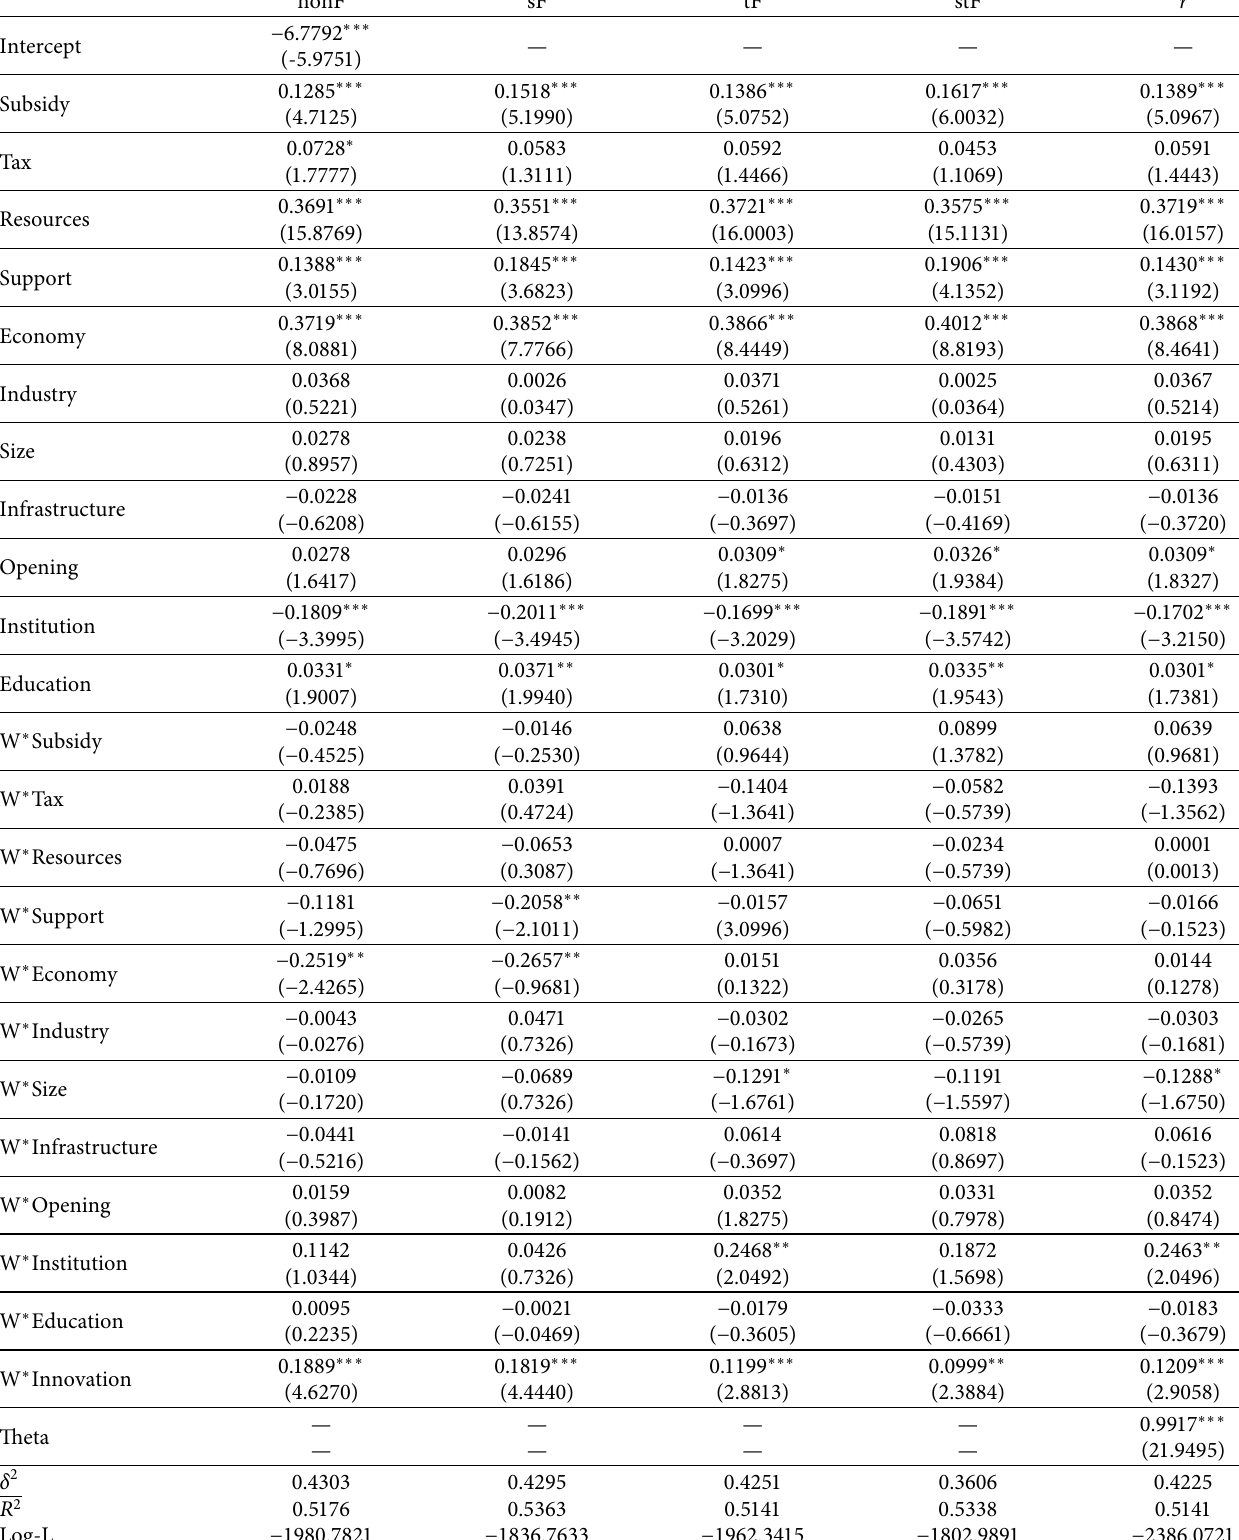
Table 11: Results of the impact of government R&D funding on the regional innovation quality